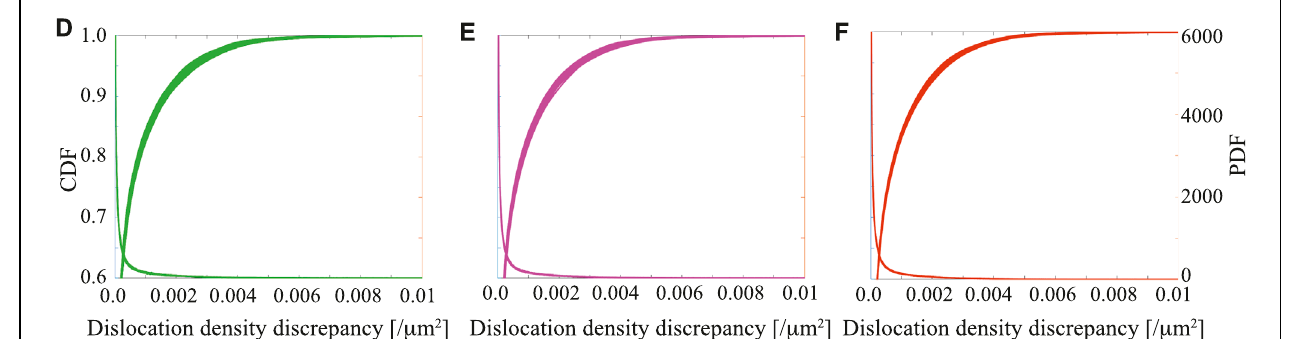
Frontiers in Materials |